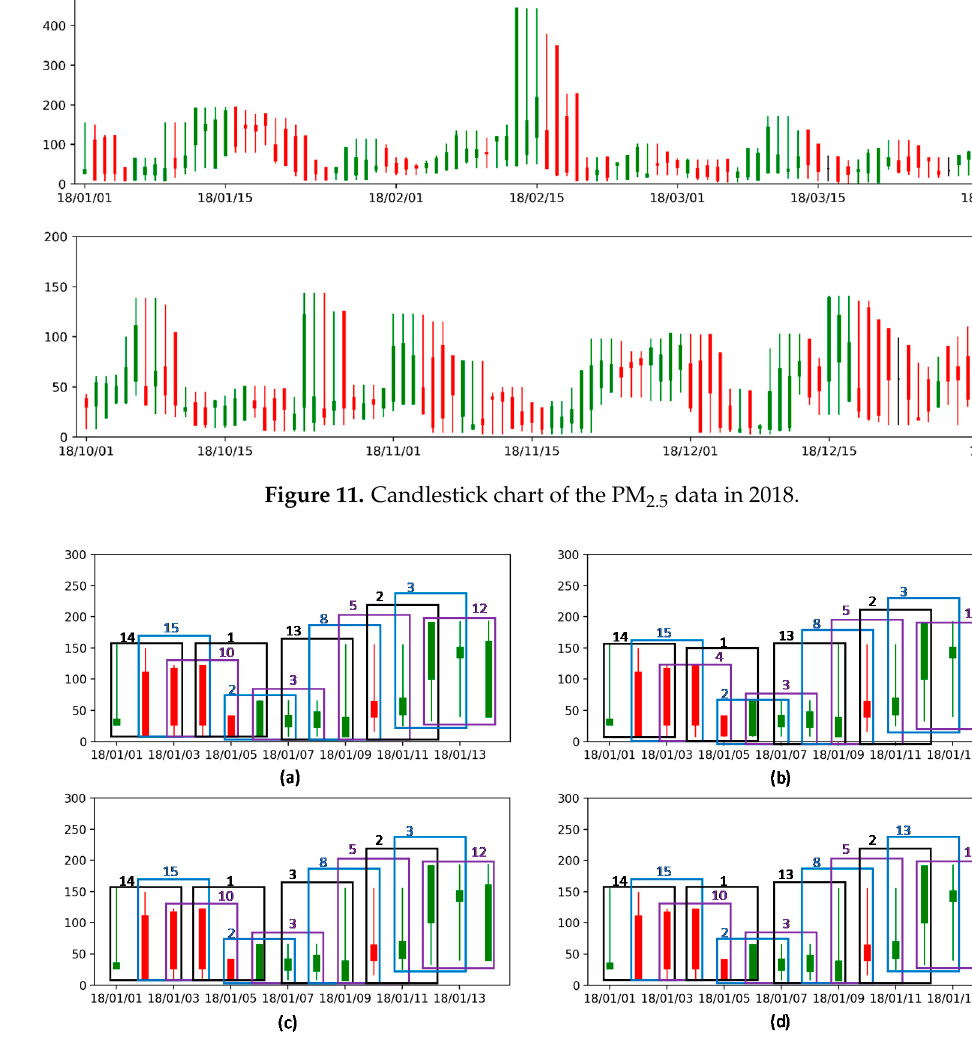
Figure 11. Partial classification results of the VGG models, ( a ) VGG, ( b ) SVM, ( c ) LeNet, and ( d ) AlexNet.